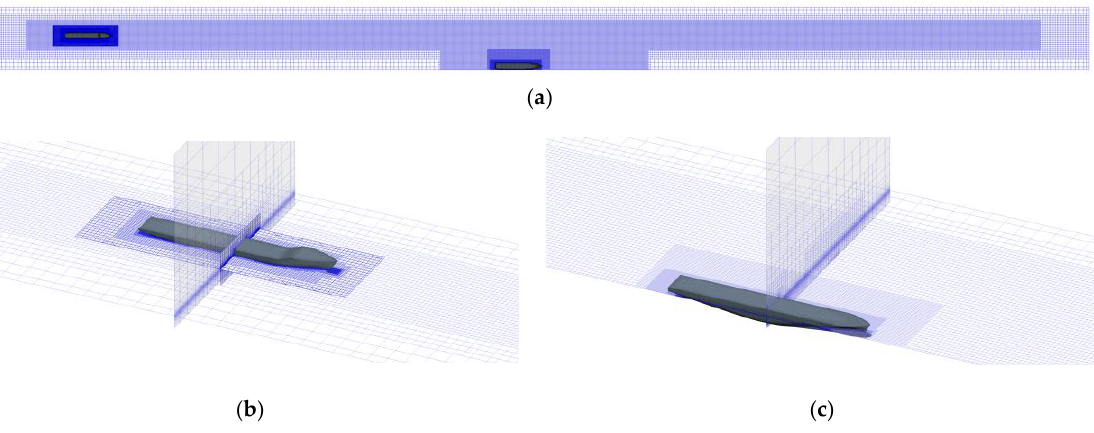
Figure 4. Mesh distributions. ( a ) Mesh distributions on the undisturbed free surface, ( b ) Mesh distributions around the passing ship, ( c ) Mesh distributions around the moored ship.